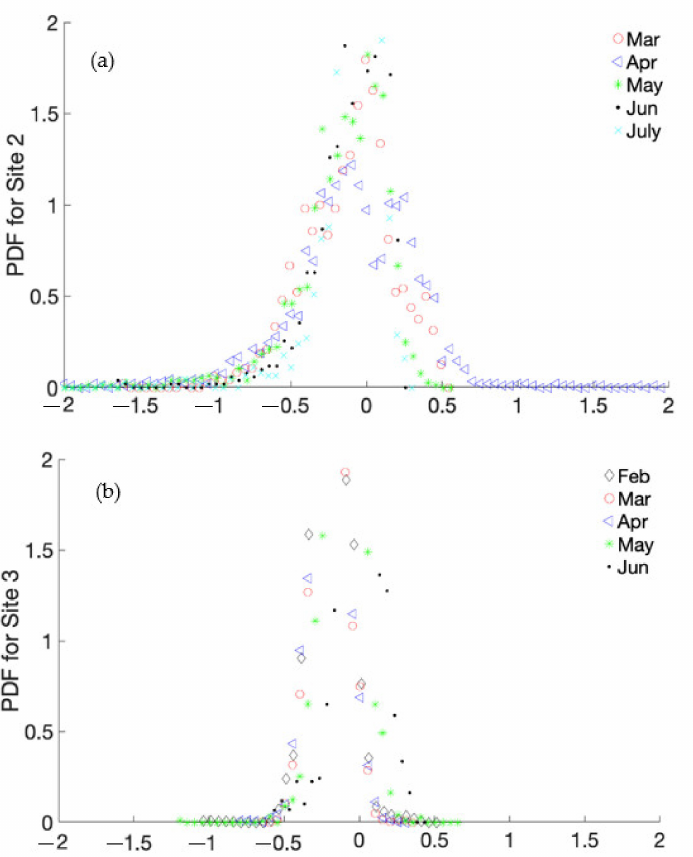
Figure 9. Probability density function (PDF) of modelling errors for sites 2 ( a ) and 3 ( b ), used for validating residential and collector sewer models,